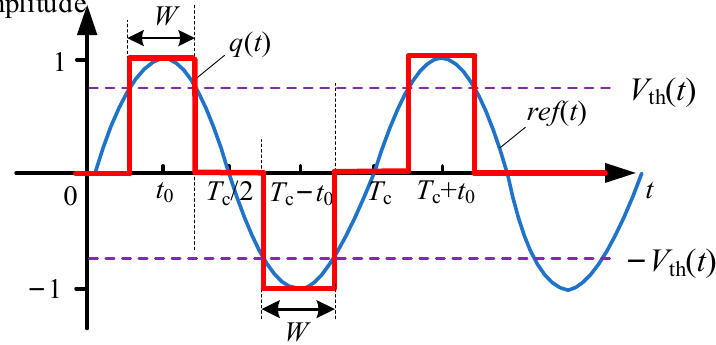
Figure 3. Diagram of any three-level pulse with threshold comparison.